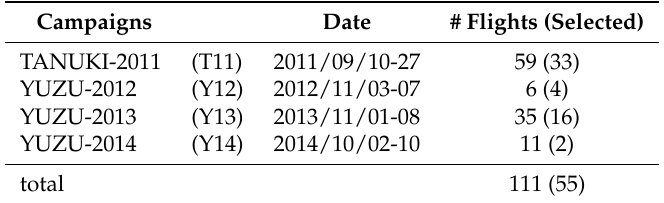
Table 1. The 111 flights during four field campaigns held at Shigaraki (Japan). The rightmost column shows the number of balloon flights and, between parenthesis, the number of retained flights for the present